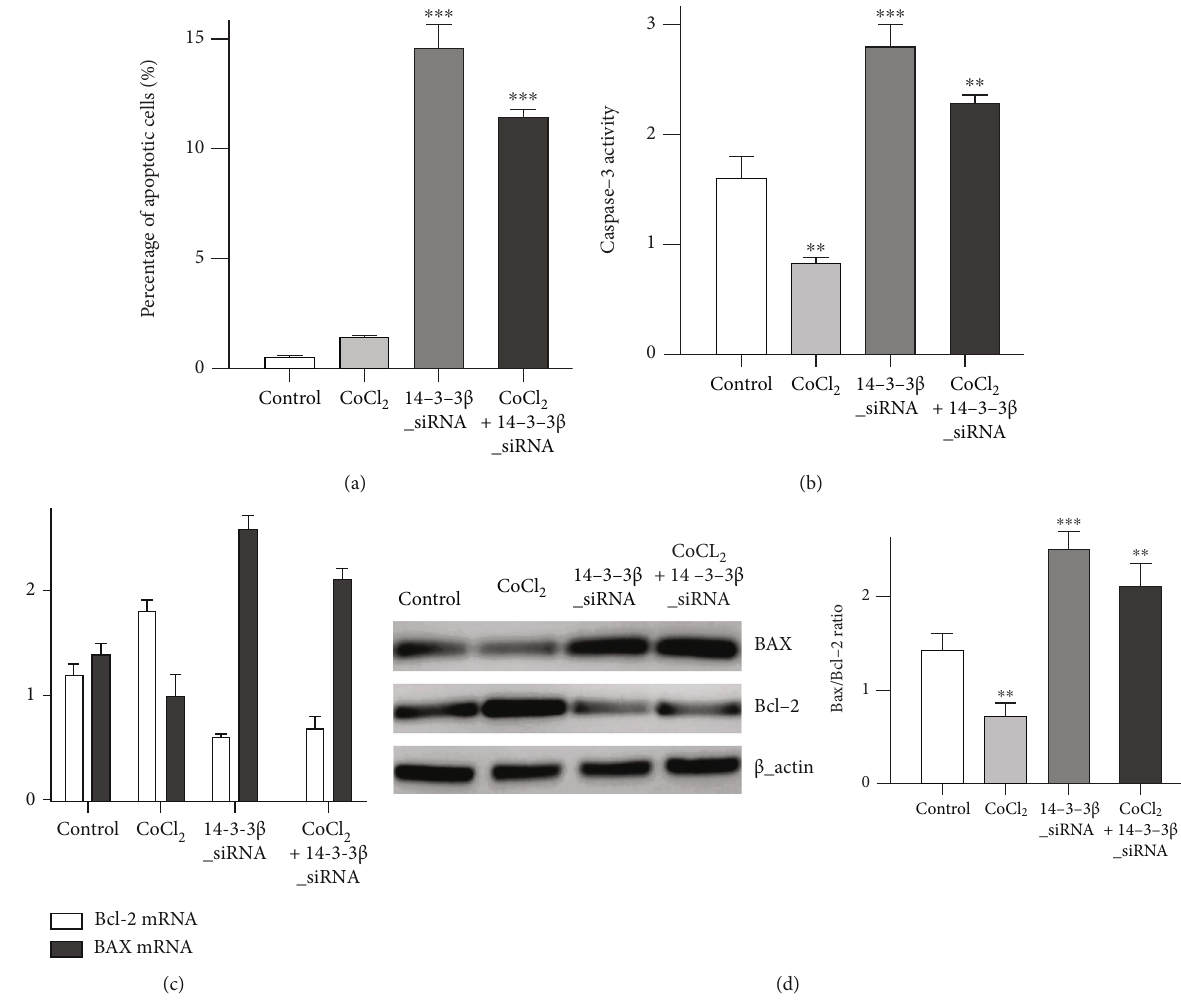
Figure 4: E ff ects on GSC cell apoptosis. (a) E ff ects of CoCl 3-3 β siRNA vs. control, P < 0 : 001 ; CoCl transfection on caspase-3 activity in GSCs (CoCl CoCl , P < 0 : 01 ). (c) E ff ects of CoCl 2 CoCl application and 14-3-3 β siRNA transfection on Bcl-2 and Bax expression in GSCs, Bax/Bcl-2 ratio was also calculated. (CoCl 2 control, P < 0 : 01 ; 14-3-3 β siRNA vs. control, P < 0 : 001 ; CoCl